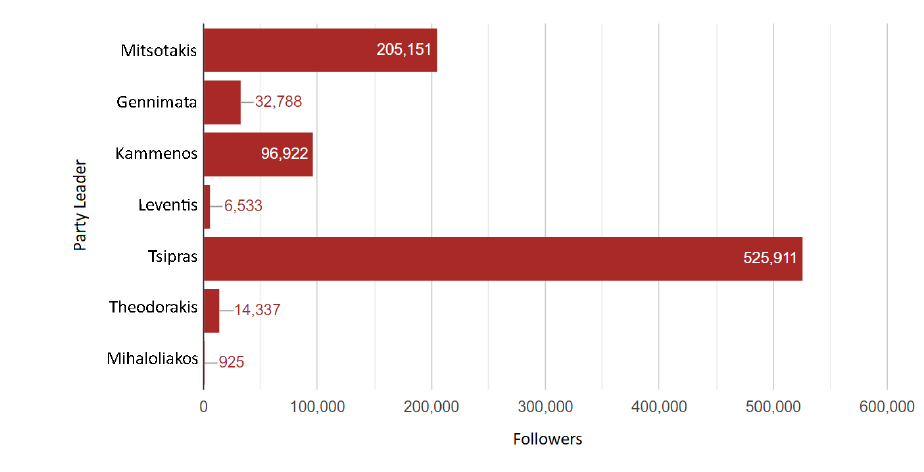
Figure 6. Followers per political leader.